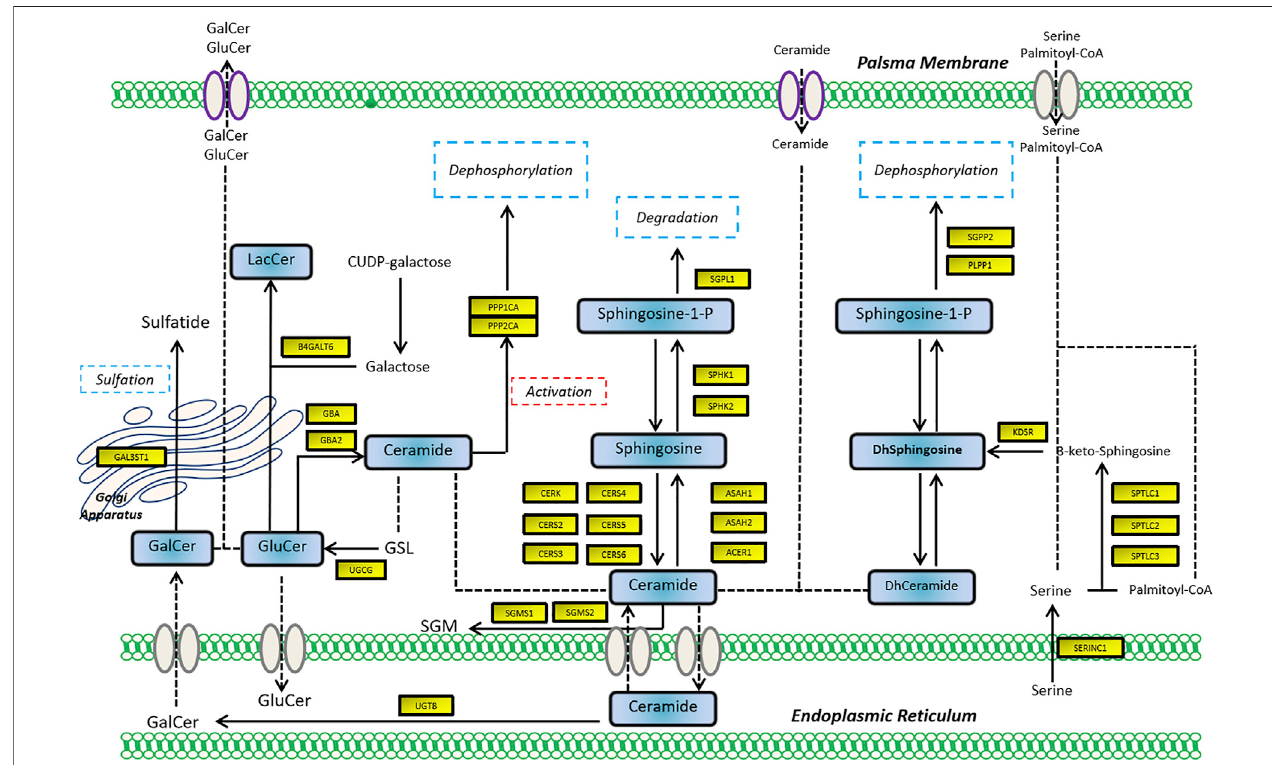
FIGURE 13 | The schematic diagram shows the biological mechanism of the sphingolipid-related genes involved in this study in human cells.